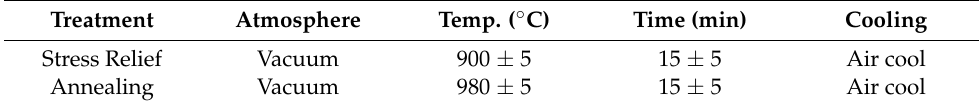
Table 1. Heat-treatment processes used for this study, informed by